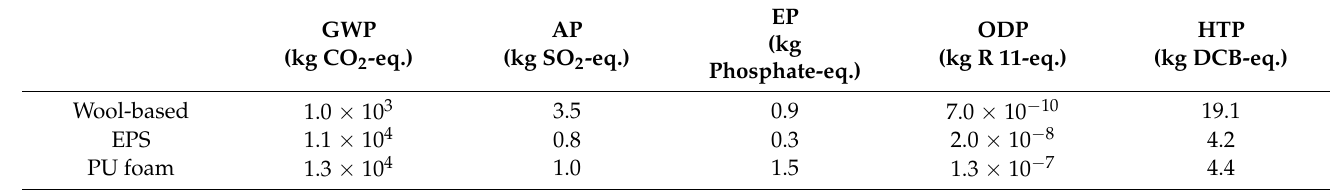
Table 5. Disposal phase.